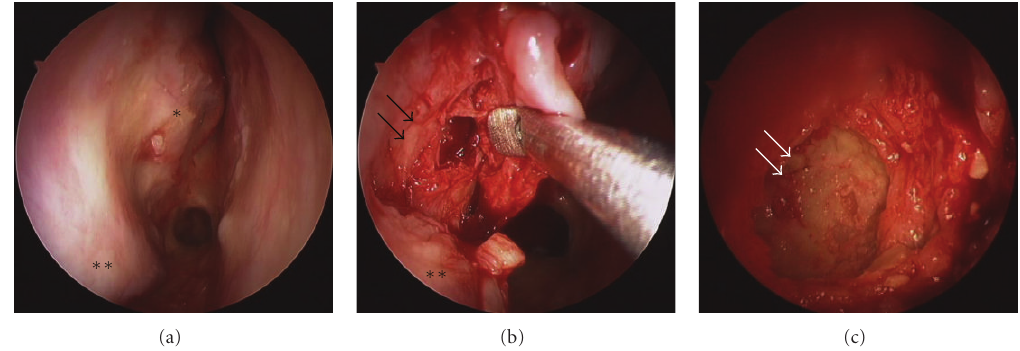
Figure 2: Operative findings. (a) Right nasal cavity; (b) a spherical bony structure occupies the right maxillary sinus (black arrows); (c) the inside of the bony ball. The wall is fragile, like an egg shell (white arrows); ∗ the remnant of the middle turbinate; ∗∗ inferior